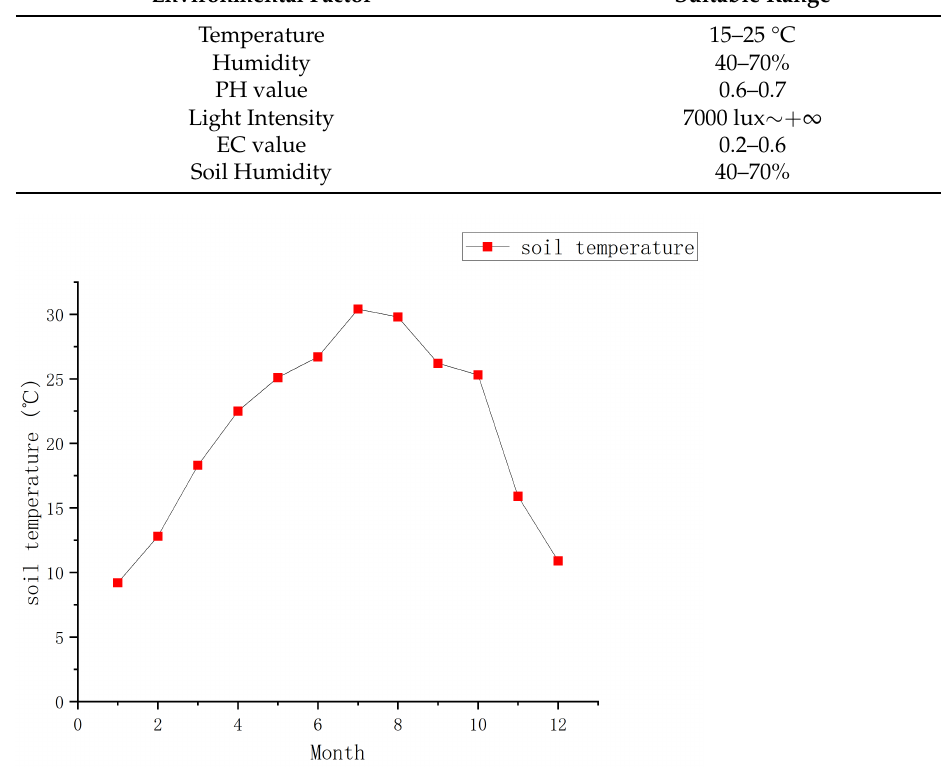
Figure 8. Annual average monthly temperature in the greenhouse where the experiment is